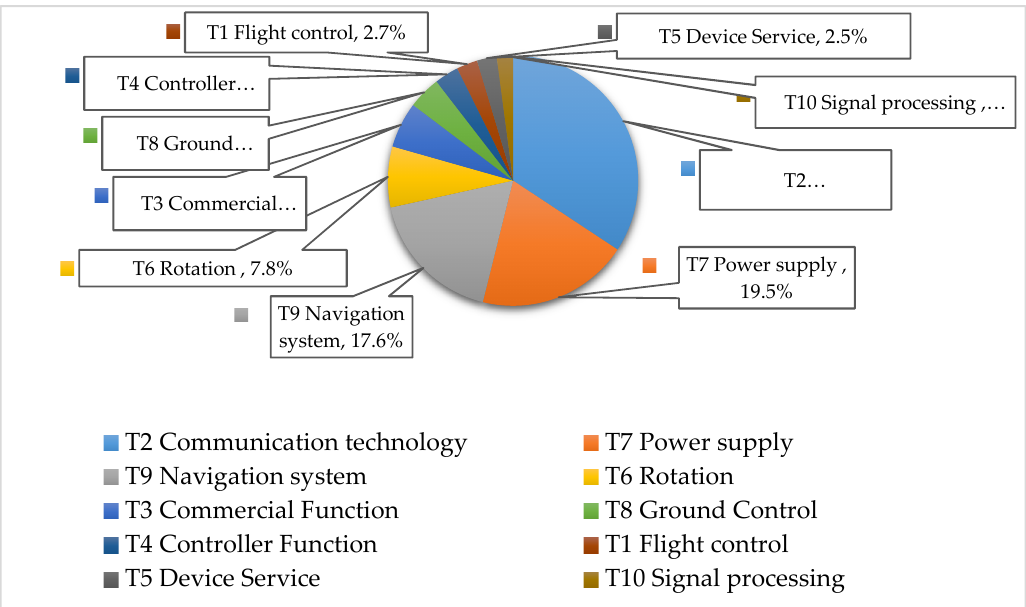
Figure 4. Topics’ ranks and percentages.